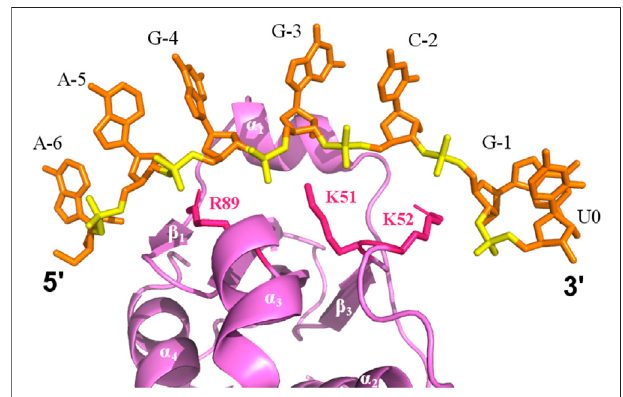
FIGURE 6 | Electrostatic binding interface of a P protein – 5 ’ leader complex in solution. The predicted structure is the best-scored model calculated by HADDOCK. The 5 ’ leader (orange sticks) lies along the β -sheet cleft of P protein (violet). Electrostatic interactions between positive charged residues of the P protein (sticks, pink) are labeled and are positioned close to the phosphate groups of the 5 ’ leader